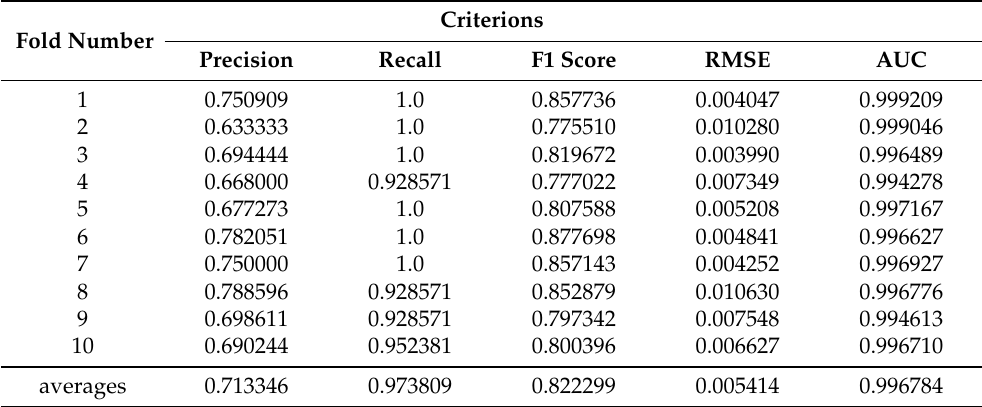
Table 5. The average criterions of 10-fold